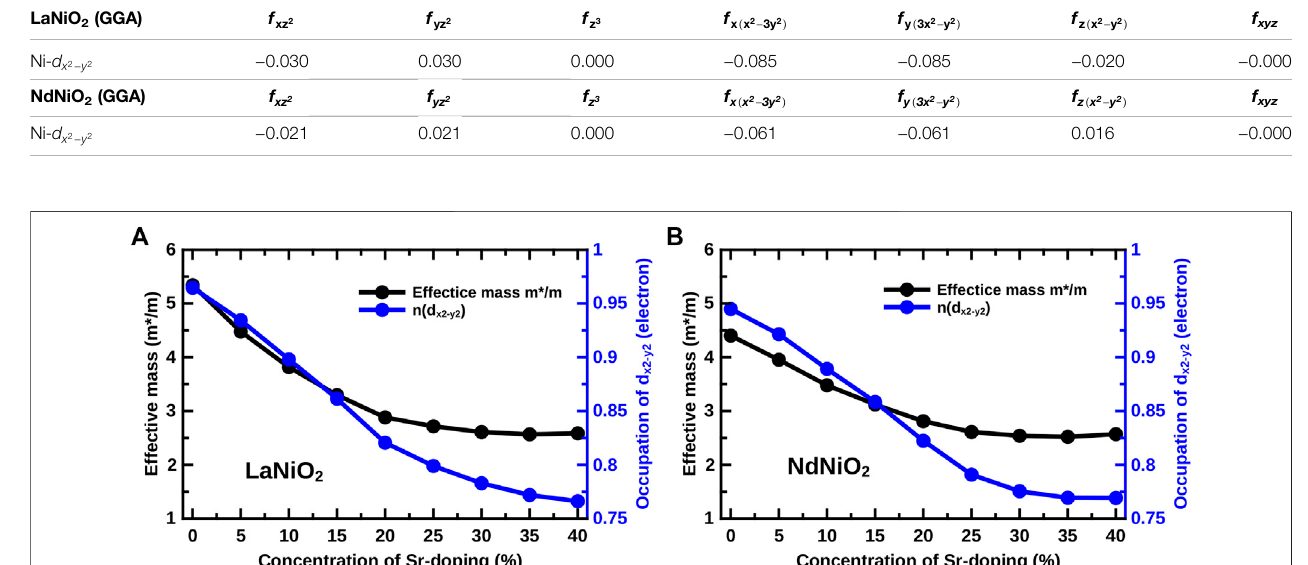
FIGURE 4 | Occupation of the Ni 3 d x 2 − y 2 orbital (blue; right y -axis) and its effective mass enhancement m */ m (cid:2) 1/ Z (black; left y -axis in panels) vs. Sr-doping for LaNiO 2 (A) and NdNiO 2 (B) as calculated in DFT + DMFT. From [33] (Supplemental material).